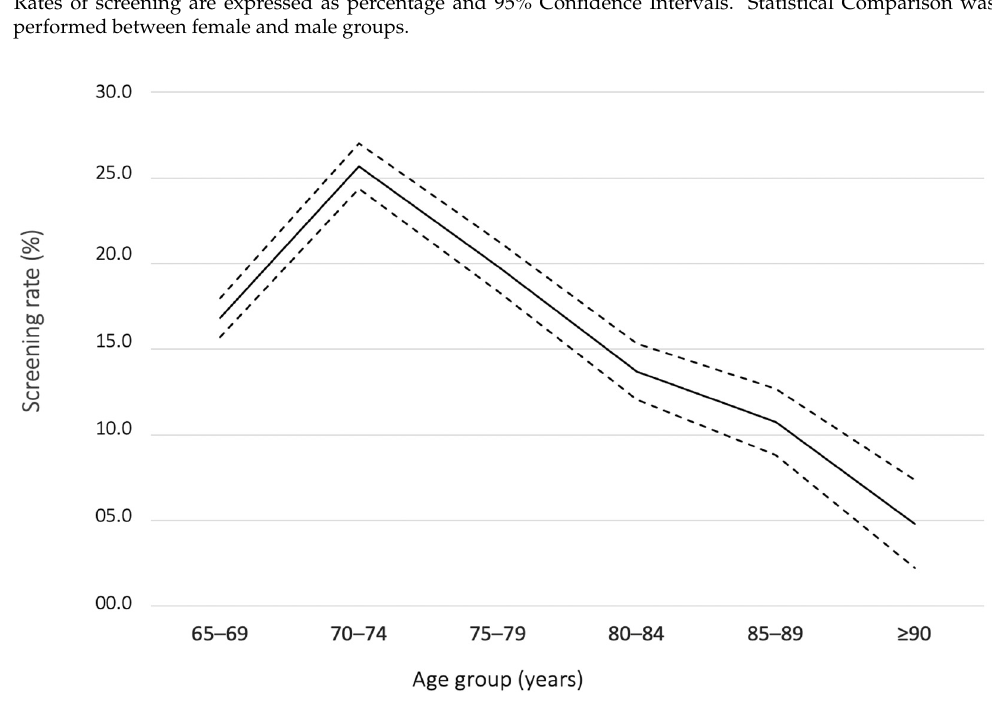
Figure 3. Atrial Fibrillation screening rates according to age group and gender. The continuous line represents the value of the screening rate in percentage and dotted lines show the upper and lower limits of the 95% confidence interval.